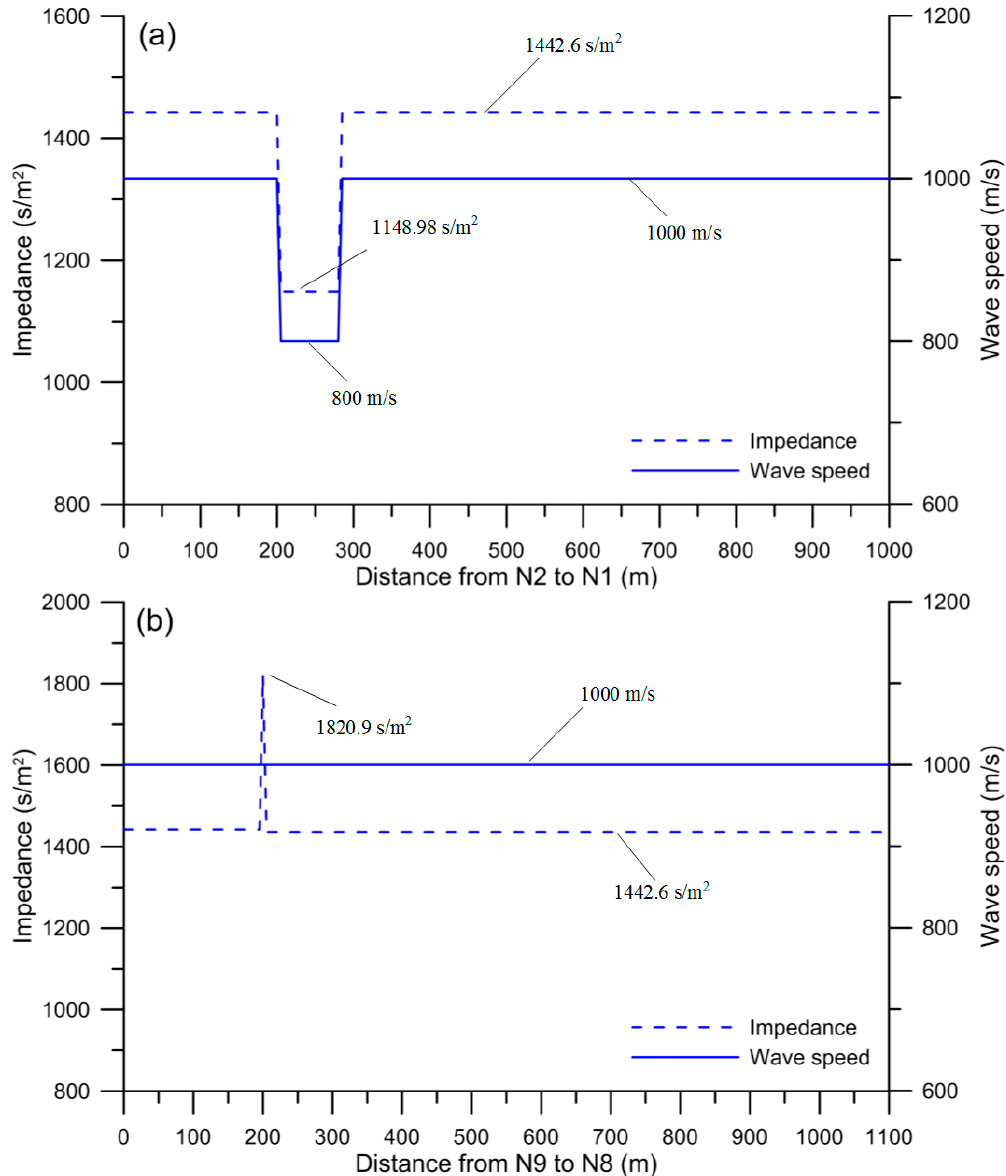
Figure 5. Impedance and wave speed along (a) P1 and (b) P10, determined by PEOS.